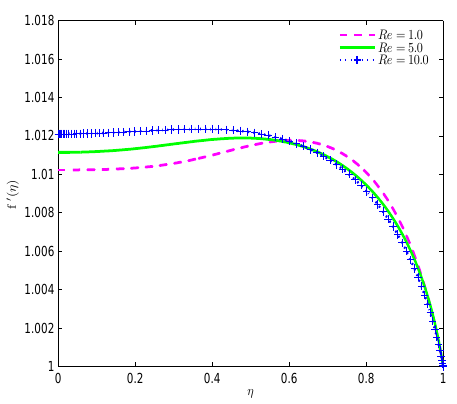
Fig. 6: Variation of f (cid:48) with K at α = 0.01 , β = 0.005 , γ = 0.01 , Re = 10.0 and Λ = 0.001